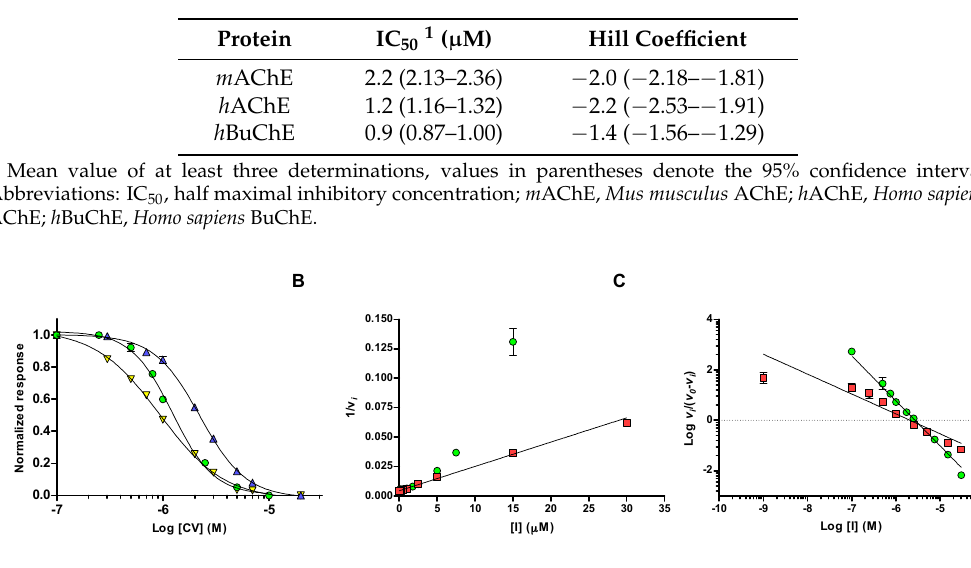
Figure 2. Dose-response ( A ) of CV binding to h AChE (green circles), m AChE (blue triangles) and h BuChE (yellow triangles). Dixon plot ( B ) and Hill plot ( C ) of CV (green circles) and Ortho-7 (red squares). In the figure, v o is the rate without any inhibitor and v i is the rate in presence of various concentrations of the inhibitor.